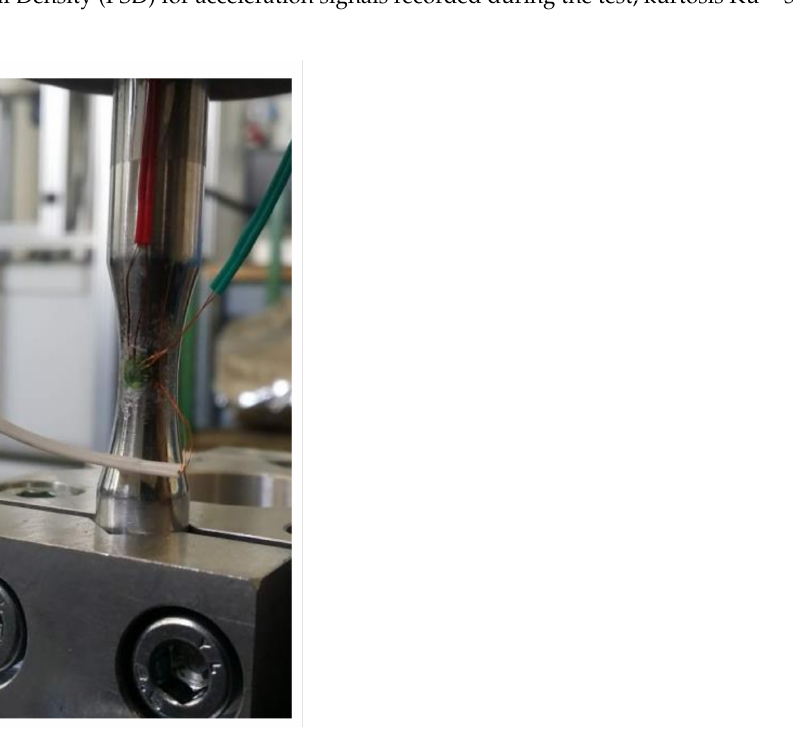
Figure 9. Specimen with a strain gauge for strain measurements during the experimental